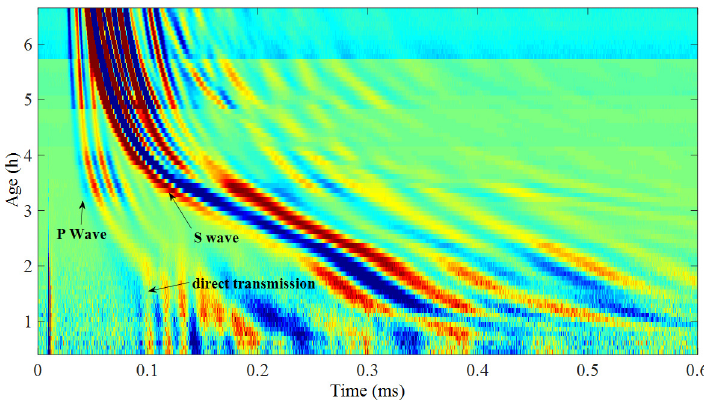
Figure 2. B scan image formed from signals getting from a mortar sample (w/c = 0.40).